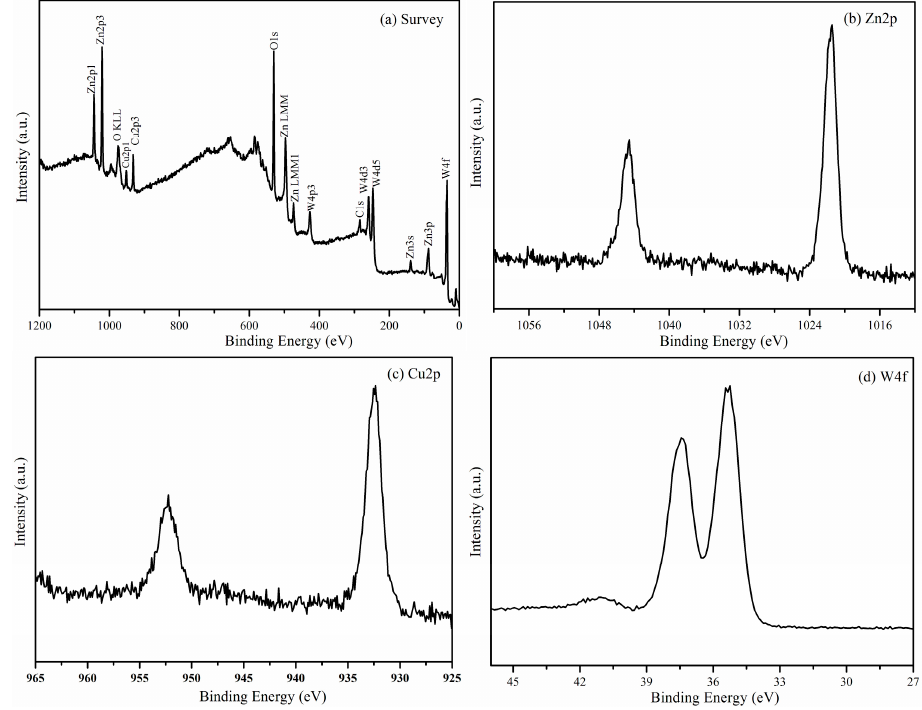
Figure 4. X-Ray Photoelectron Spectroscopy (XPS) spectra of Cu 2 O/ZnWO 4 sample: ( a ) Survey of the sample; ( b ) Zn 2p; ( c ) Cu 2p and ( d ) W 4f.